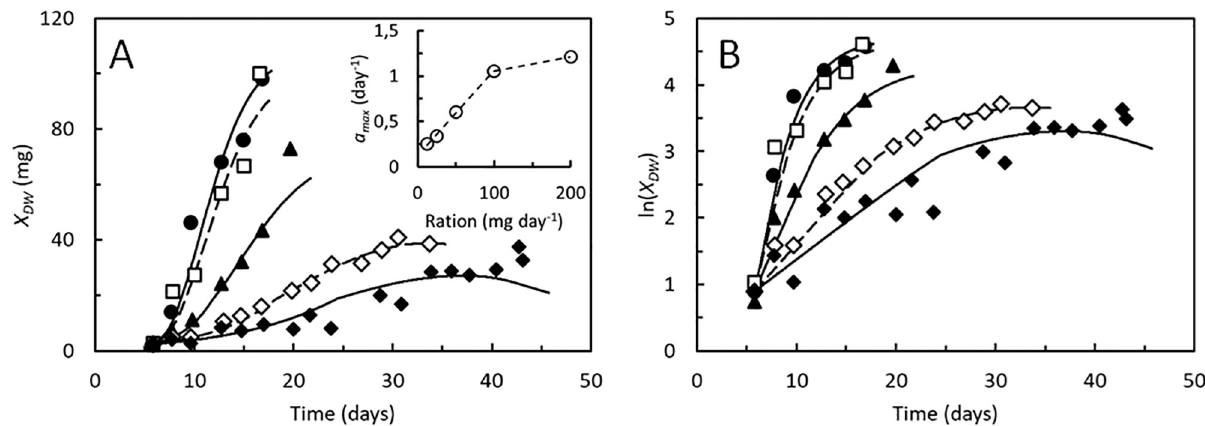
Fig 4. Hermetia illucens. A. Dry weight, X DW and B. Logarithmic transformed dry weight of BSF larvae supplied a daily substrate ration of 12.5 ( ◆ ), 25 ( ◇ ), 50 ( π ), 100 ( □ ), or 200 ( ● ) mg day -1 per individual [10]. Growth curves were modelled using identical parameters, except for the maximal specific feed up-take rate, which for each condition was estimated as the value giving the best fit to the data, resulting in a max = 0.25, 0.34, 0.60, 1.06, and 1.21 day -1 , respectively, for larvae fed the daily rations described above (inset A). Parameters shown in Table 2.